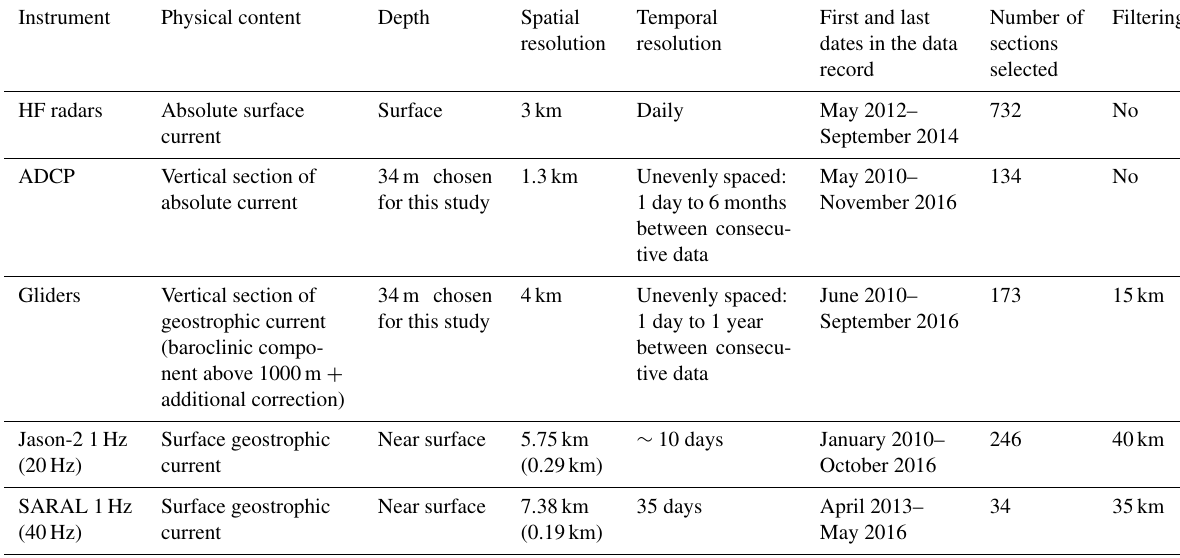
Table 1. Main characteristics of the different current datasets used in this study. Instrument First and last